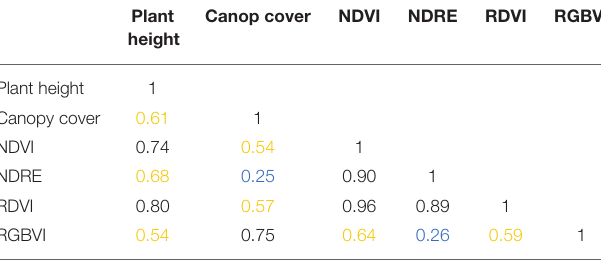
TABLE 3 | Correlation matrix of candidate predictors in biomass prediction. Plant